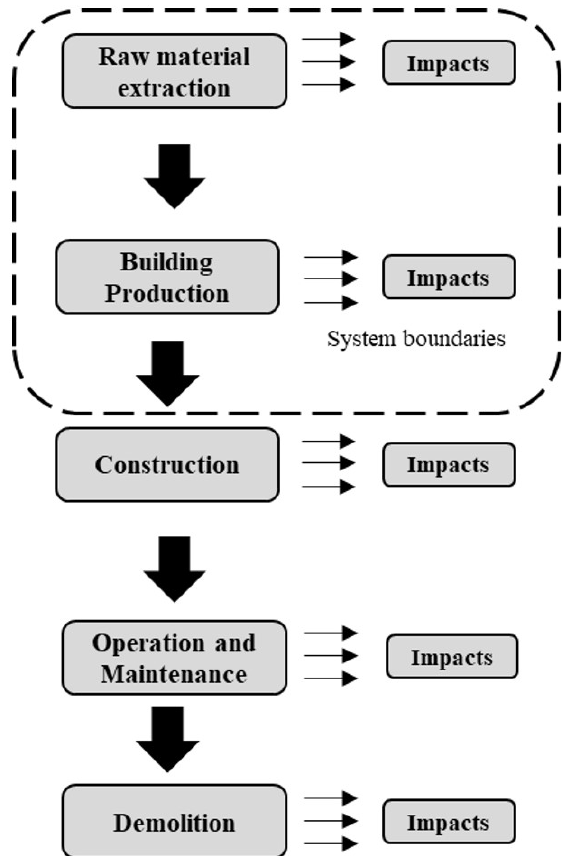
Figure 2. System boundaries of the LCA